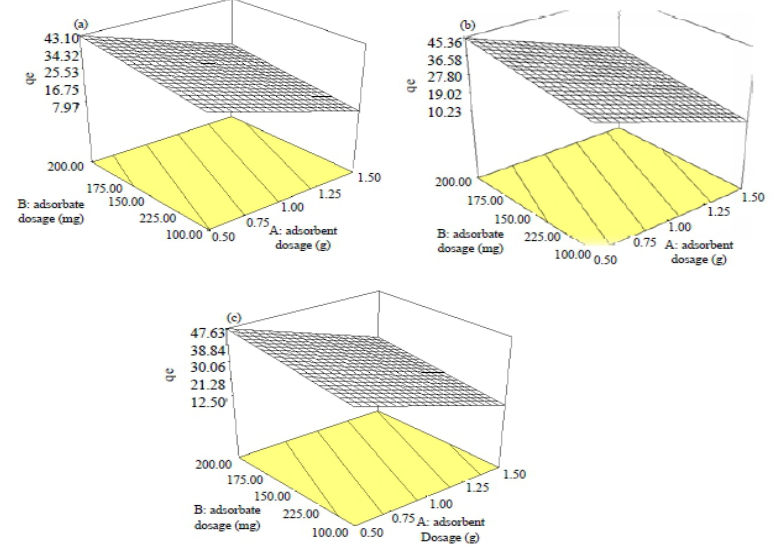
Fig. 5. Response surface plot for adsorption capacity of ammonia nitrogen